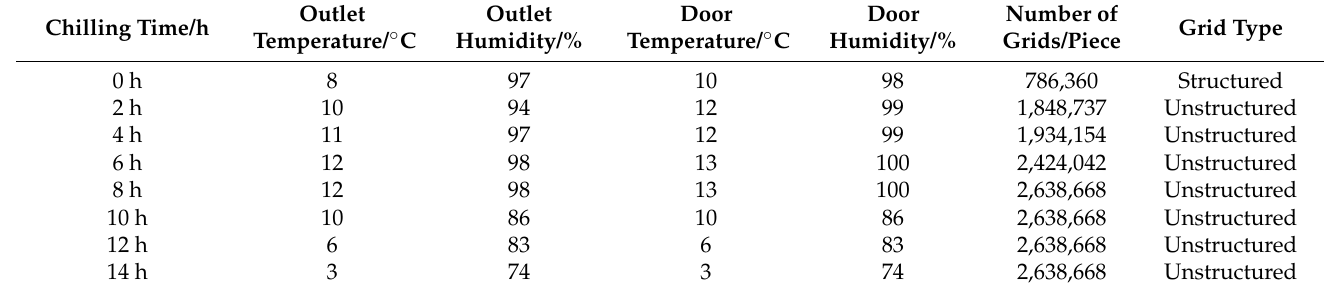
Table 2. Measured values of temperature and humidity at the outlet and door and grid division of the chiller.